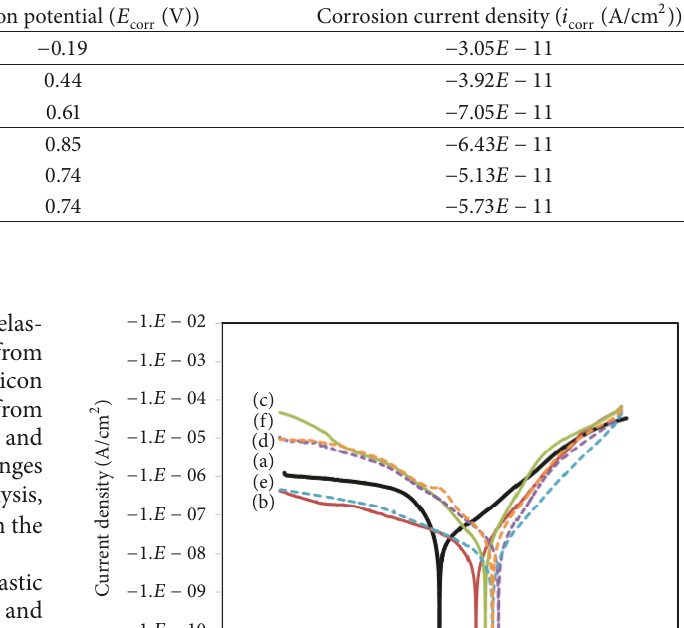
Table 4: Electrochemical parameters of all films.